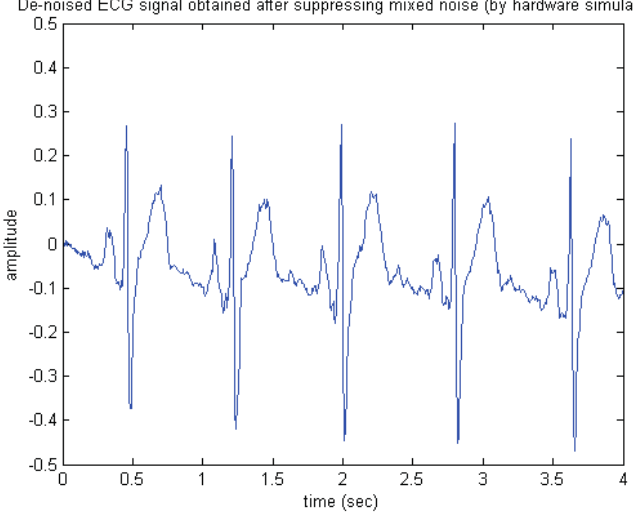
Figure 15. De-noised ECG signal obtained after suppressing mixed noise (by hardware